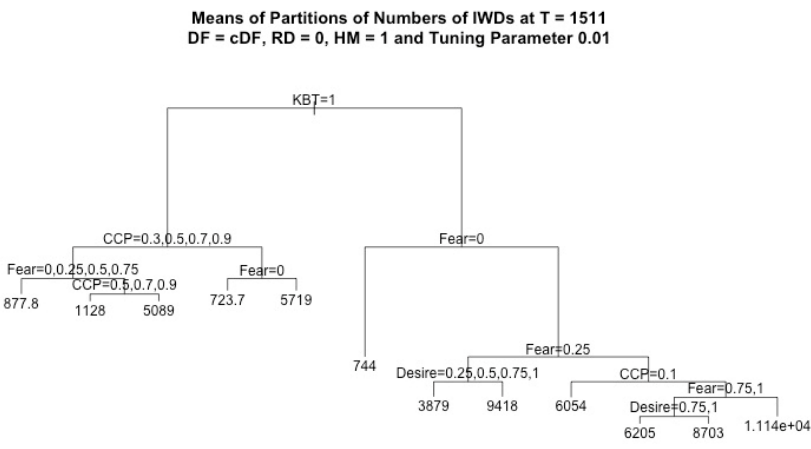
Figure 7. Tree model for means of partition numbers of IWDs at the simulation end with parameters